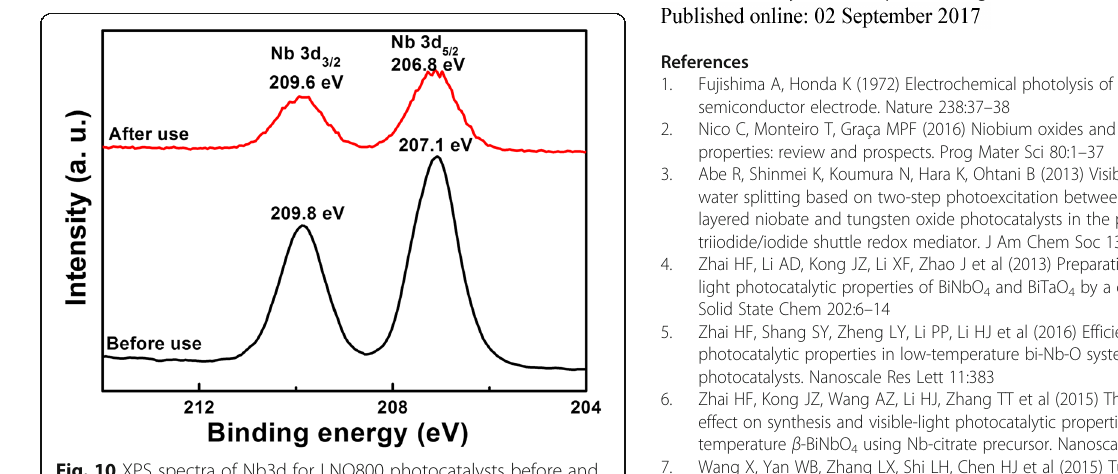
Fig. 10 XPS spectra of Nb3d for LNO800 photocatalysts before and after photo-degradation of MB under UV